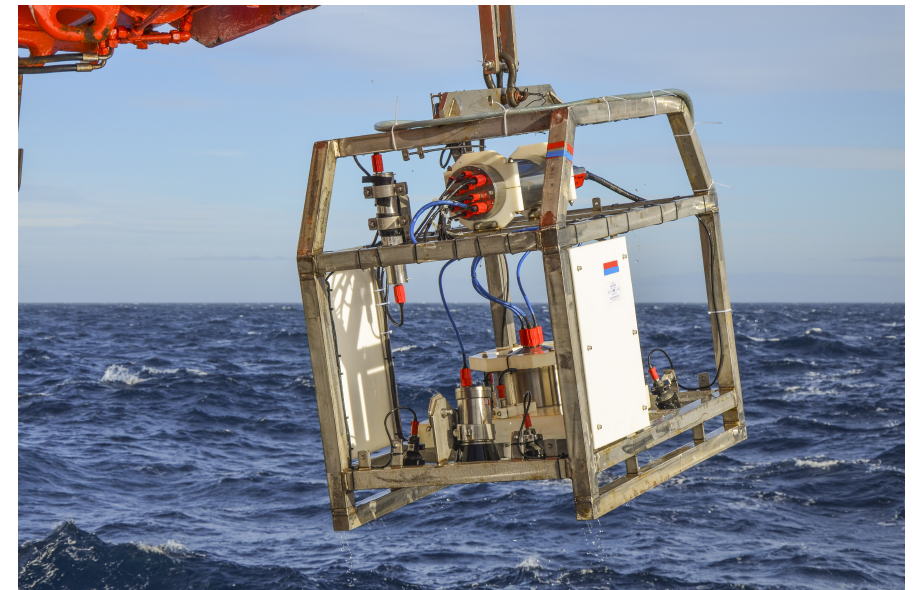
Figure 1. The Ocean Floor Observation System (OFOS) of the Alfred Wegener Institute (AWI), Helmholtz Centre for Polar and Marine Research Bremerhaven, deployed from the RV Polarstern during cruise PS81 in the waters off the northern Antarctic Peninsula from January to March 2013 (photo: A.